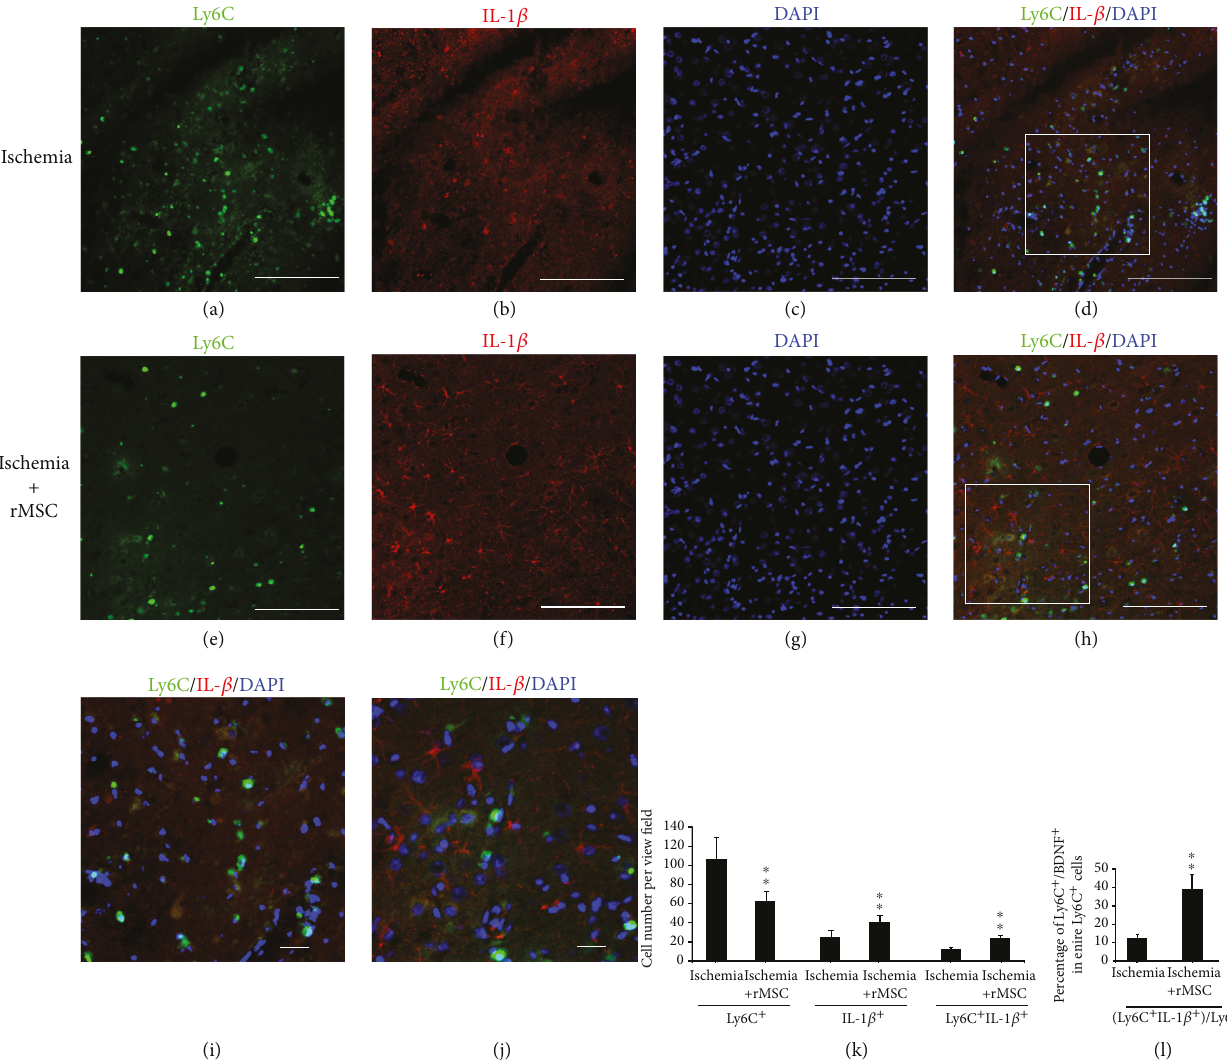
Figure 4: MSC treatment reduces the quantity of Ly6C + cells but increases the proportion that produces IL-1 β at day 2. (a – d) Distribution of Ly6C + and IL-1 β + cells in the infarct before MSC treatment. (e – h) Distribution of Ly6C + and IL-1 β + cells in the infarct after MSC treatment. (a, e) Ly6C staining. (b, f) IL-1 β staining. (c, g) DAPI nucleus staining. (d) Double-stained Ly6C + /IL-1 β + cells scattered in the infarct area 2 days after dMCAO. (h) Ly6C + /IL-1 β + cells in the infarct area 2 days after MSC transplantation. (i) The magni fi ed image of the square in (d). (j) The magni fi ed image of the square in (h). (k) Ly6C + cell number was reduced in the infarct area 2 days after MSC transplantation, but the quantity of IL-1 β + cells and IL-1 β + /Ly6C + cells was increased in the infarct area. (l) The percentage of Ly6C/IL-1 β double-positive cells among the whole Ly6C + cells was increased by MSC treatment. ( ∗ p < 0 05 and ∗∗ p < 0 01 , as compared with the ischemia vehicle group). Arrow: double-labeled cells. n = 5 ; scale bar: (a – h) 250 μ m and (i, j) 50 μ